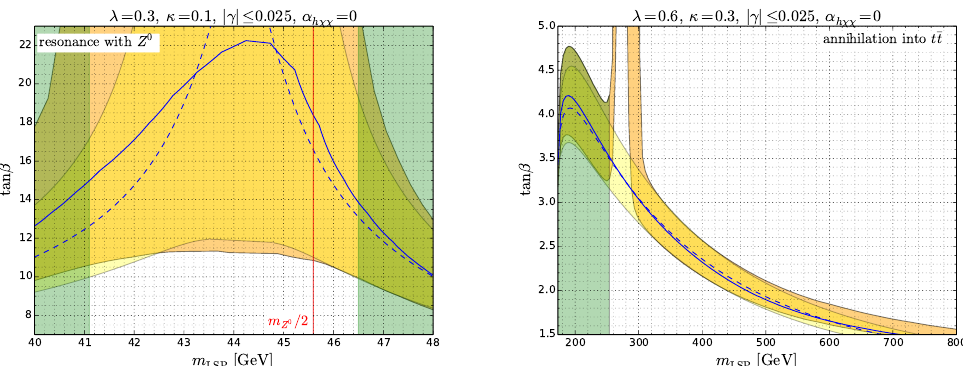
Figure 4 . The same as in (cid:12)gure 3 but now the regions with non-zero s - h mixing are depicted by colored areas: orange (yellow) corresponds to the results from MicrOMEGAs (from eqs. (3.6) and (3.15)). We took m (cid:31) > 0, (cid:22) > 0, m s = 600 GeV and j (cid:13) j (cid:20) 0 : 025 (corresponding to j (cid:1) mix j . 1 GeV), where (cid:13) < 0 ( > 0) refers to the lower (upper) limit of a given area. The shift of the orange region with respect to the yellow one for LSP masses above about m s is due to the annihilation channels containing s in the (cid:12)nal state and co-annihilation e(cid:11)ects which become more important for larger LSP